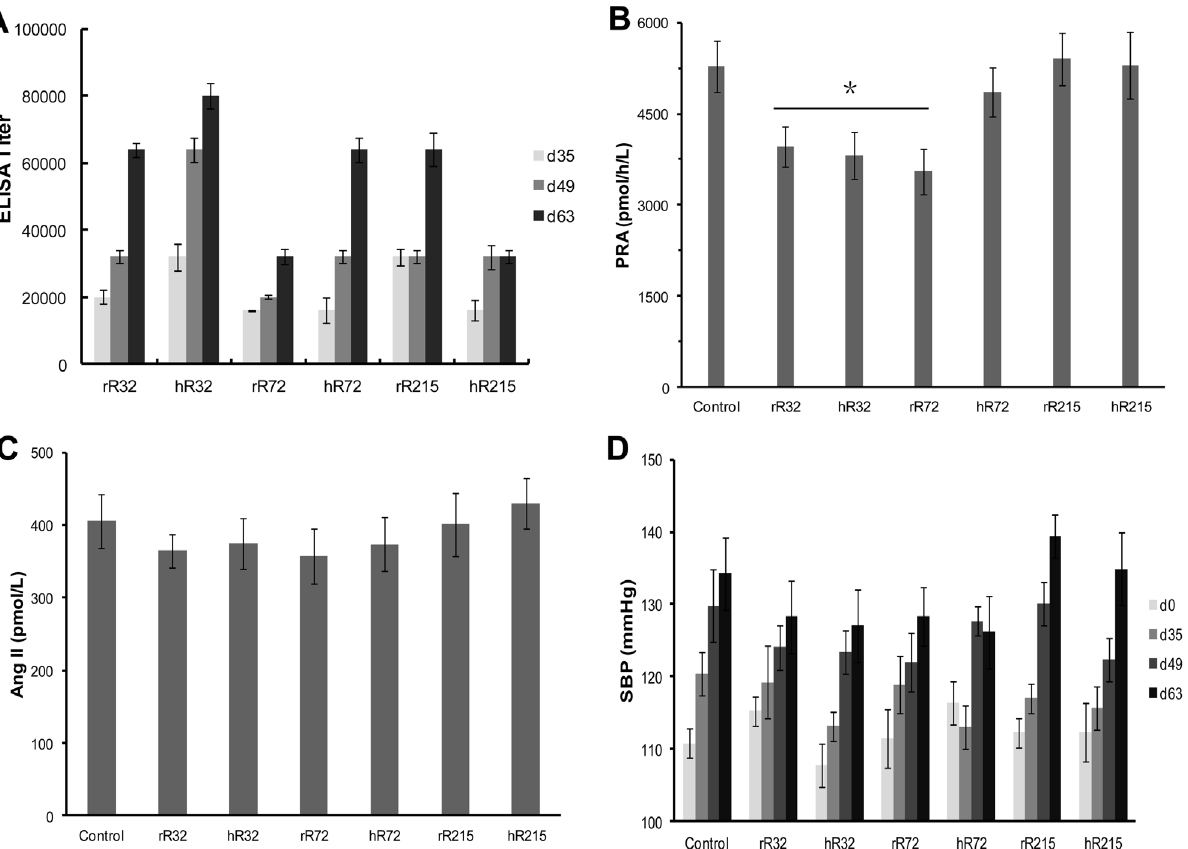
Figure 1. The antisera titers against peptides and the PRA and Ang II concentration of SD rats. A. Antibody titers were determined for antisera on days 35, 49, and 63. The six peptides antisera gave a significant A/A 0 ratio in ELISA at dilutions ranging from 1:32,000 to 1:80,000 on day 63. B and C. On day 63, compared with the control group, the PRA was significantly decreased in the R32 and rR72 groups ( B ), while Ang II concentration only tend to be decreased in these groups ( C ). No obvious changes were observed in the hR72 and R215 groups. D. The BP levels had no prominent difference among groups. * P , 0.05 vs the control group.